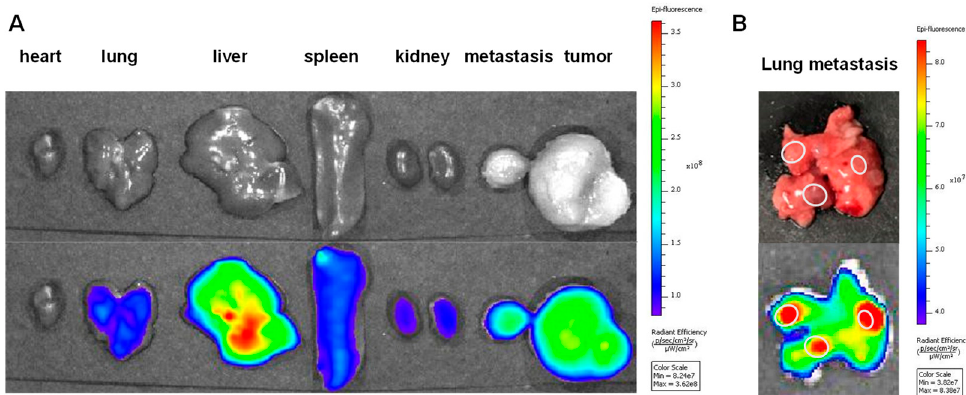
Figure 6. Accumulation of Ce6-PCL-NE in metastatic tumors of 4T1 tumor-bearing mice. ( A ) Ex vivo fluorescence images of the dissected tumors including primary/metastasis tumors and major organs (heart, lung, liver, spleen, and kidney) 12 h post-injection of Ce6-PCL-NE into 4T1 tumor-bearing mice. ( B ) Ex vivo fluorescence image of lung metastasis after intravenous injection of Ce6-PCL-NE into 4T1 tumor-bearing mice.